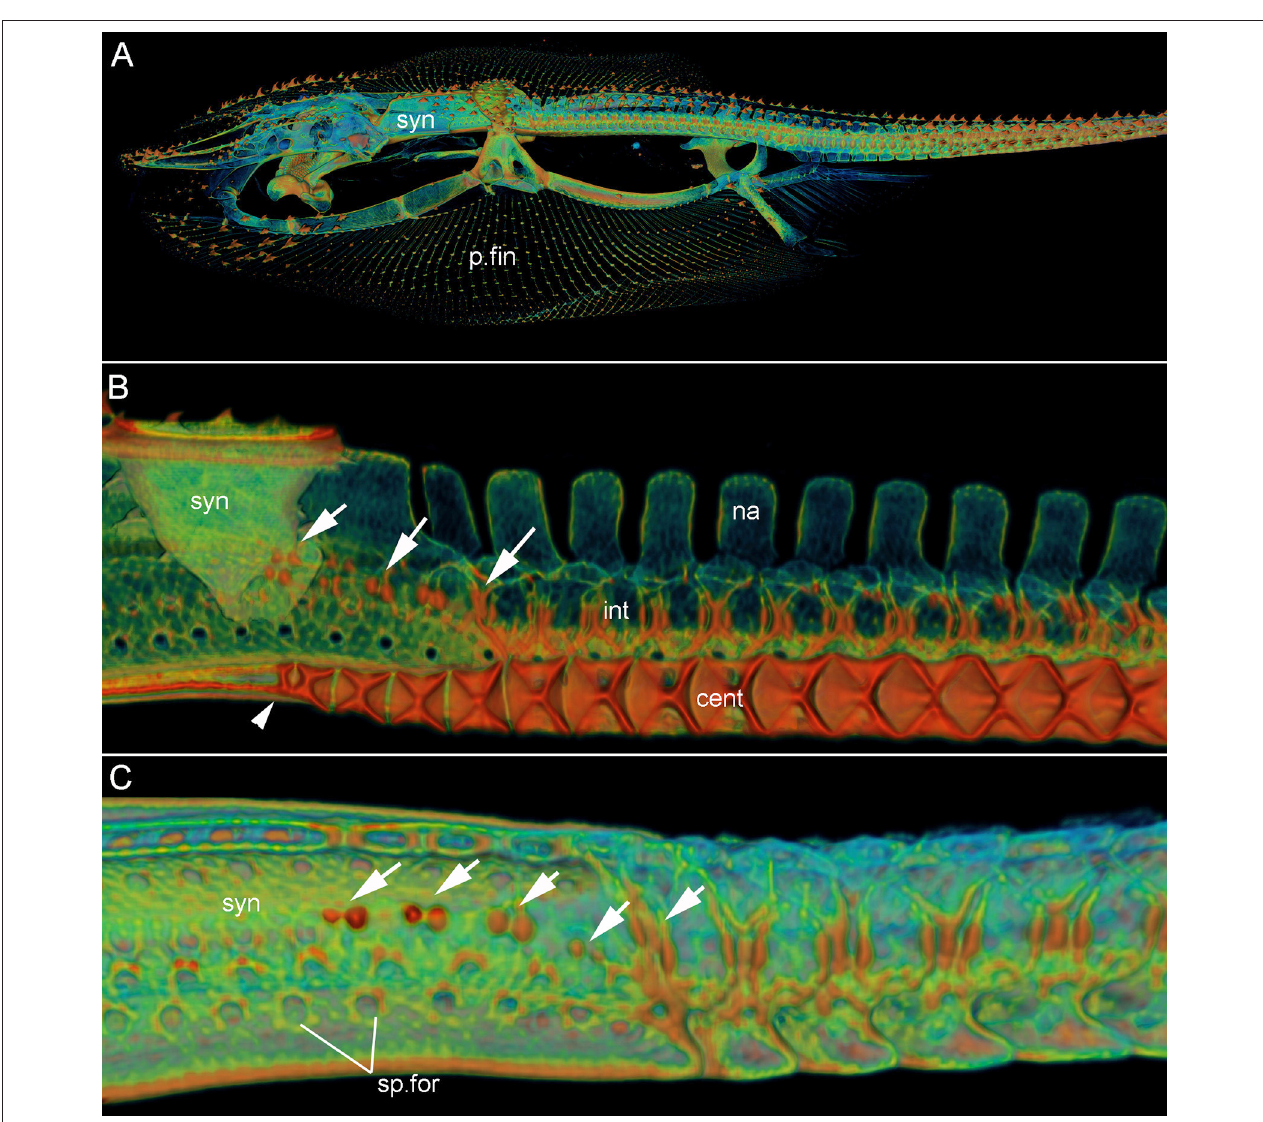
FIGURE 2 | Leucoraja erinacea , adult (BMNH 2018.9.26.1), 3D rendered µ CT scans, false colored. (A) Lateral view, entire specimen; (B) lateral view, sagittal section through synarcual and anterior vertebrae; (C) lateral view, synarcual and anterior vertebrae. White arrows indicate vertebral mineralization within the synarcual (marking sp.for2), continuous with mineralization in unfused vertebrae more posteriorly. Abbreviations as in Figure 1 , also: int, intervertebral element. Anterior to the